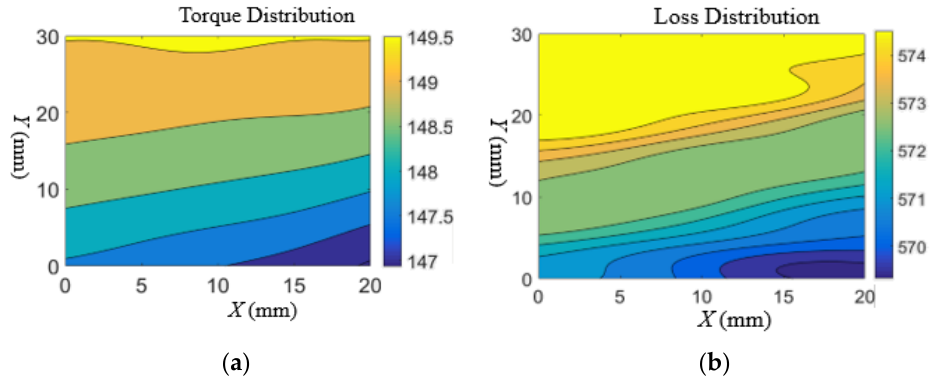
Figure 5. Preliminary surrogate results. ( a ) Torque contour; ( b ) Loss contour.